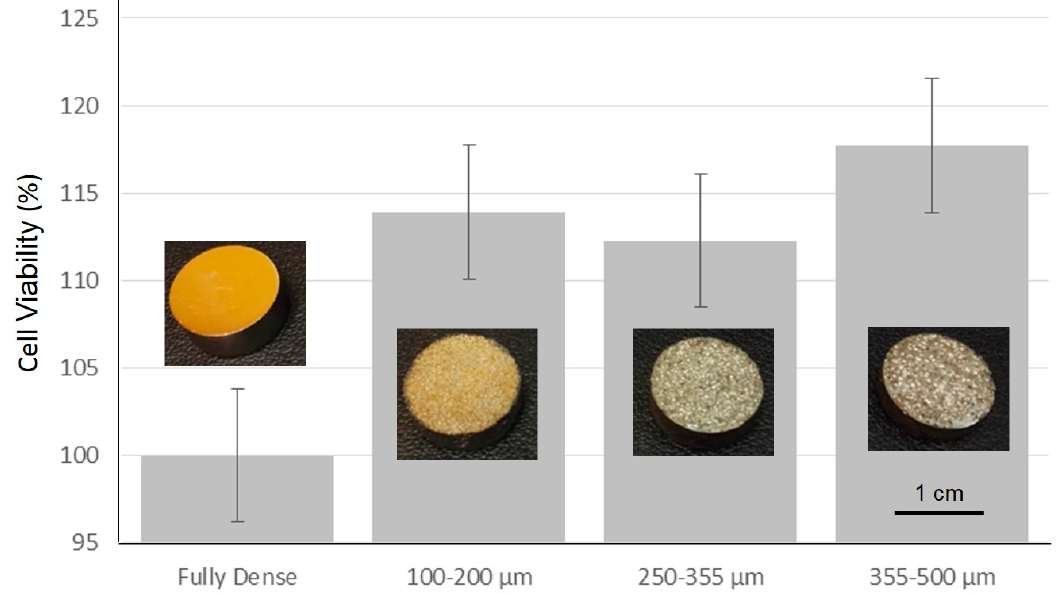
Figure 8. Cell viability quantification of preosteoblast MC3T3 growing on fully-dense and porous substrates after 4 days of cell incubation. ( A ) Representative images from a macroscopic point of view. ( B ) Percentages of cell viability. No statistics differences were observed between surfaces ( p > 0.05), however, porous substrates reached higher percentages than the control fully-dense surface. Common scale bar for all the images.